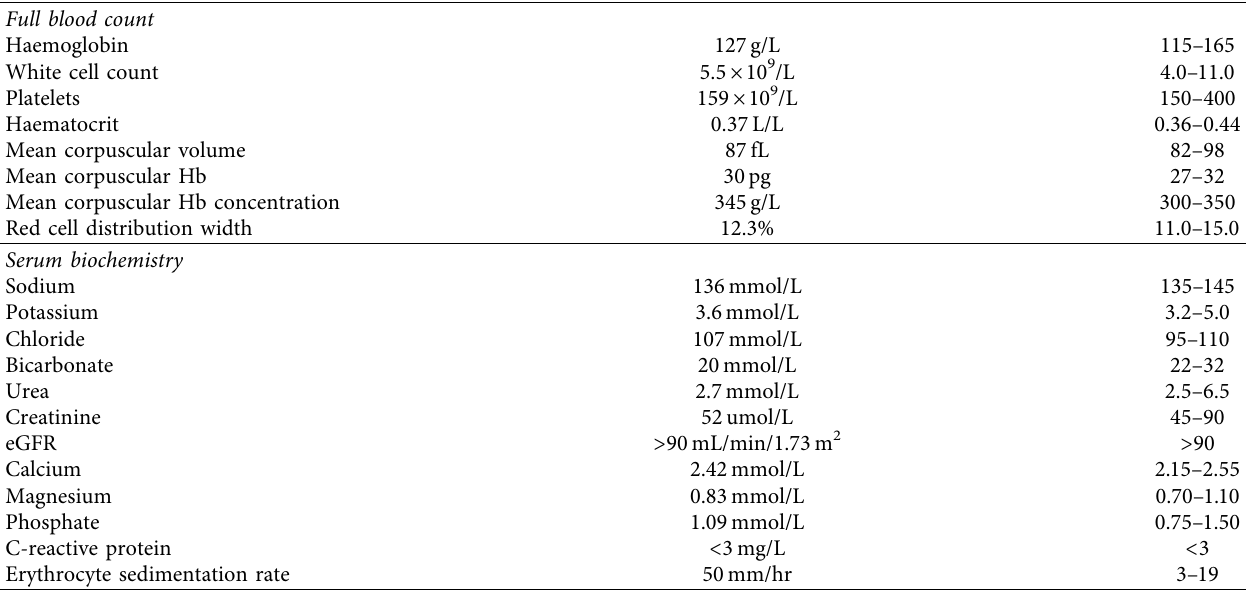
Table 2: Baseline laboratory